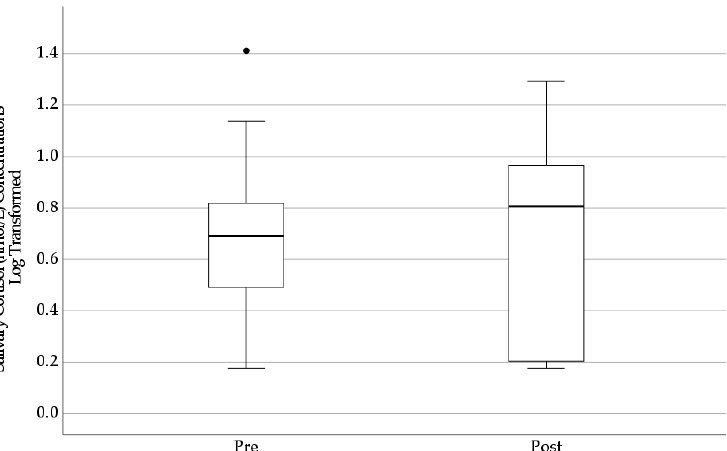
Figure A1. Box plot showing changes in the mean salivary cortisol concentrations for spring goose harvesting activities.